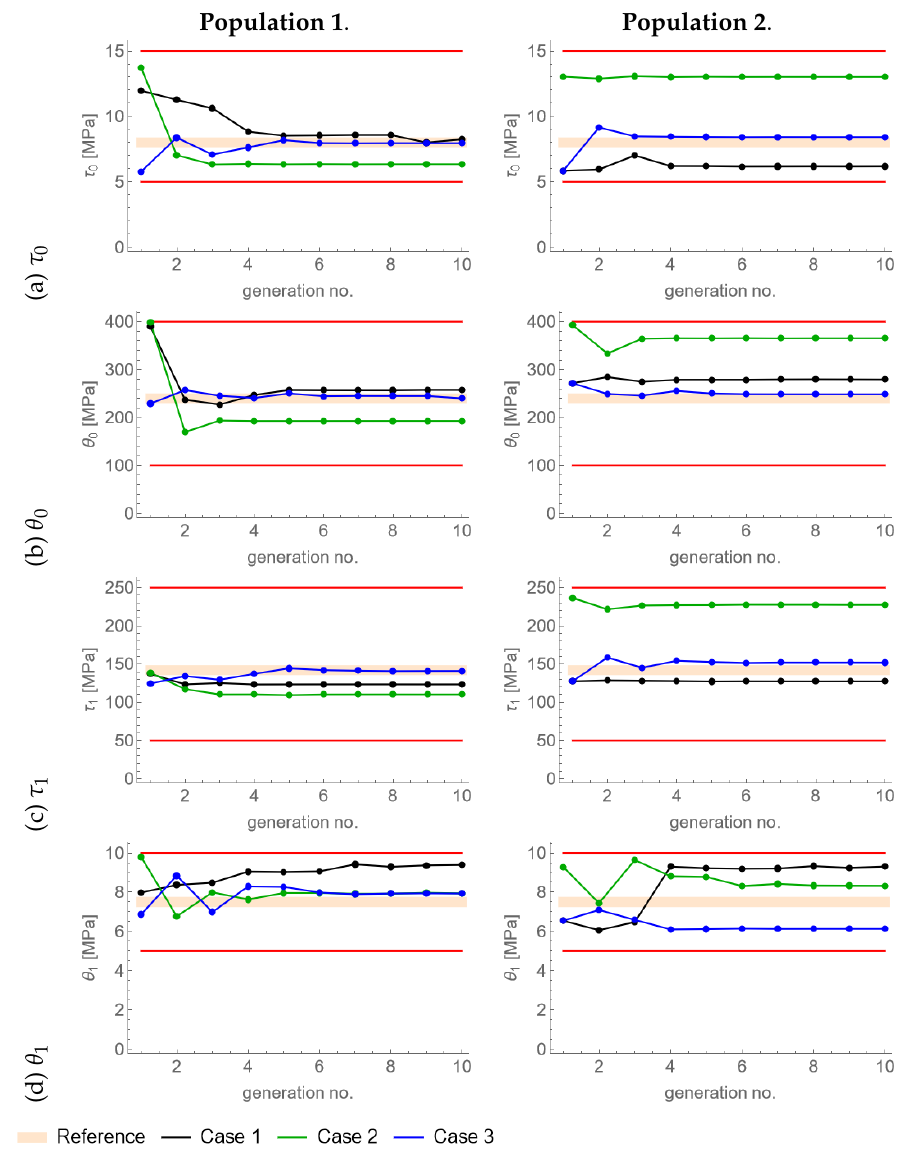
Figure 8. The values of the parameters obtained at each generation of each EA run. The ranges of parameters are shown in red and the reference parameter value in light orange (thick